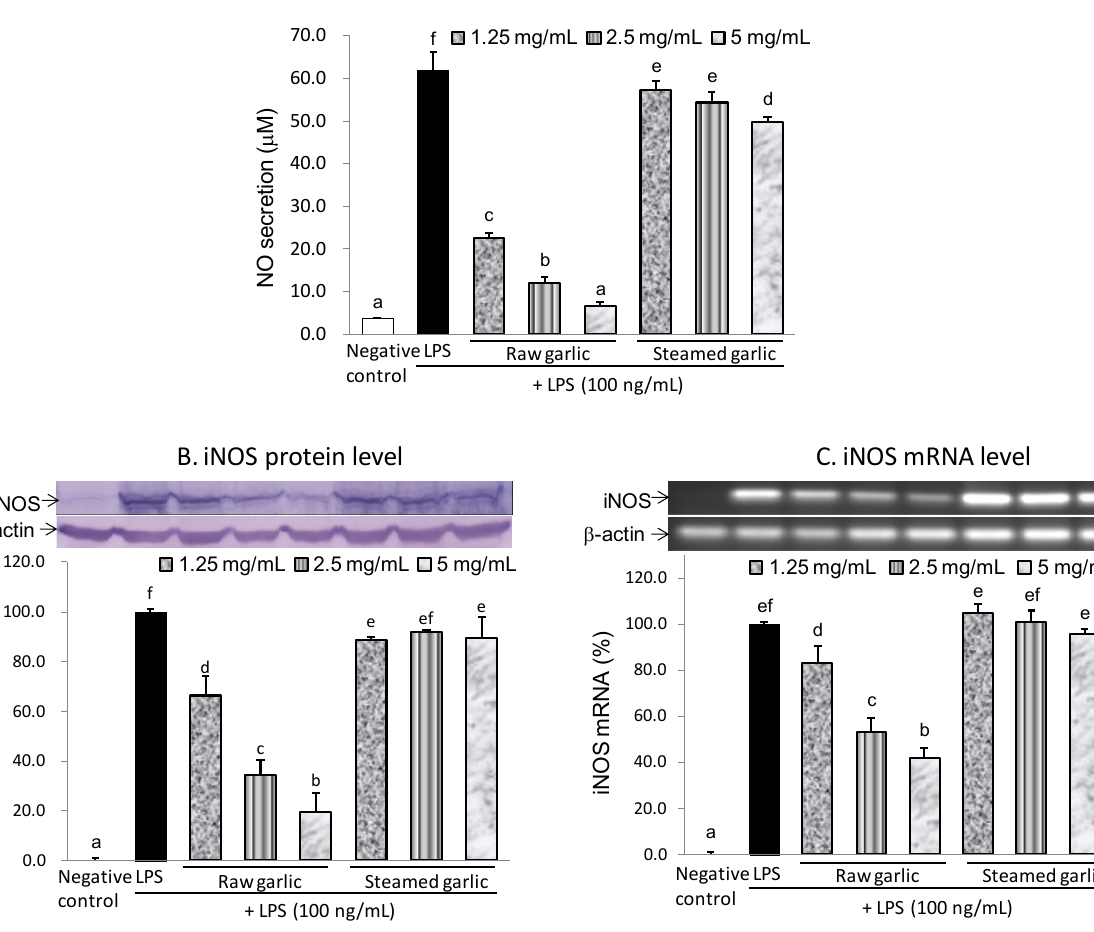
Figure 2. Effects of raw and steamed garlic extracts on the NO production ( A ); iNOS protein ( B ) and iNOS mRNA ( C ) levels in LPS-activated BV2 microglia. The treatment concentrations of garlic extract are 1.25–5 mg/mL. The values are expressed as means ± SD of triplicate tests. Means not sharing a common letter are significantly different ( p < 0.05) when analyzed by ANOVA and Duncan’s multiple range test.